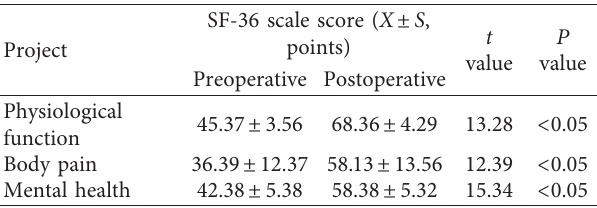
Table 1: Comparison of SF-36 scale scores of 19 patients with femoral infectious bone defect before operation and last follow-up.